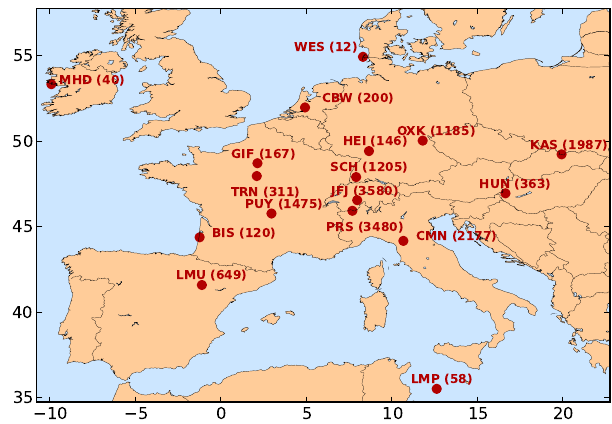
Fig. 1. European domain and localisation of the CarboEurope IP atmospheric stations used for the inversion of NEE. The height of the stations is given in ma . s . l . between parentheses.